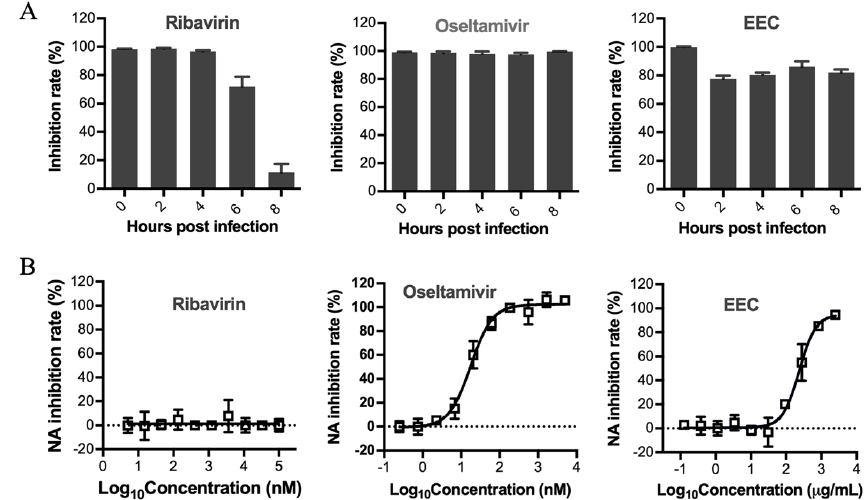
Figure 3. EEC a ff ects the late stage of the influenza virus life cycle by inhibiting neuraminidase activity. The stages of the influenza virus life cycle a ff ected by EEC were determined by time of addition assay and neuraminidase inhibition assay, respectively. ( A ) In the time of addition assay, pre-cooled MDCK cells were infected with PR8 virus at an MOI of 0.1 at 4 ◦ C for 1 h. Three IC 50 of ribavirin, oseltamivir, and EEC were added in each group at di ff erent time points during virus replication on MDCK cells. The supernatants were collected at 12 hpi, and the viral yield was determined by the NA activity assay. ( B ) In the neuraminidase inhibition assay, 95 µ L of H1N1 PR8 virus solution of 10 5 TCID 50 / mL was mixed with 5 µ L of serially diluted EEC, ribavirin or oseltamivir, respectively.